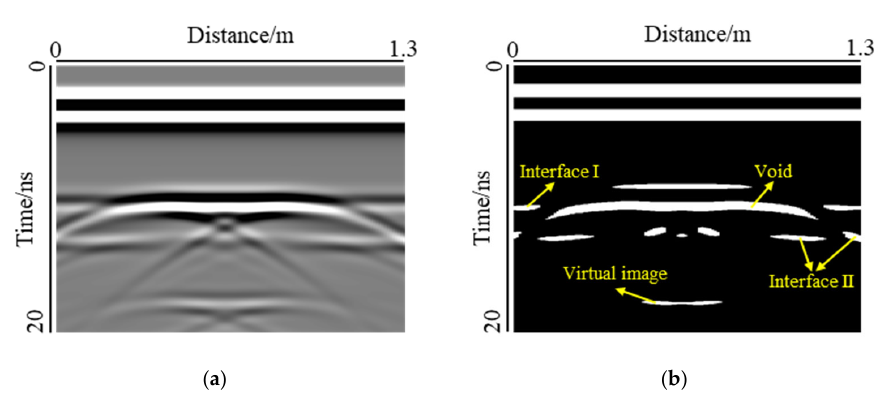
Figure 13. Binarization treatment: ( a ) Forward result ( b ) Binary image. In a binary image, the white area represents a stronger GPR response.